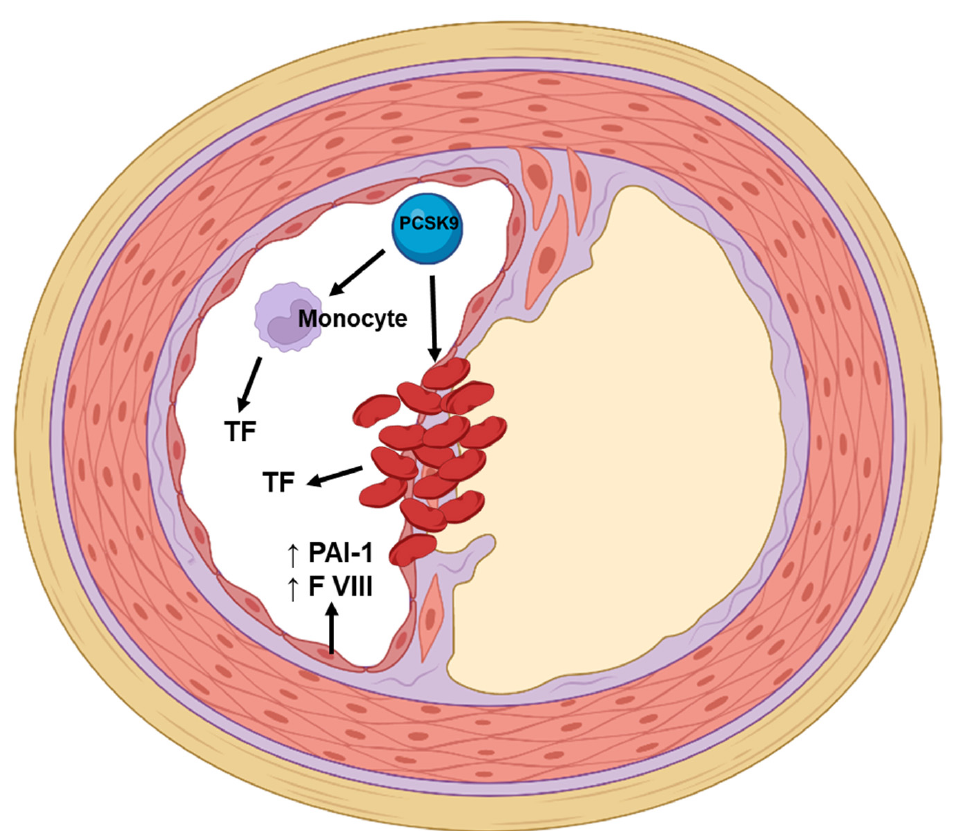
Figure 3. The role of PCSK9 in coagulation and fibrinolysis. PCSK9 induces the production of tissue factor, which is responsible for the activation of the extrinsic coagulation pathway and thrombus formation. TF, tissue factor; PAI-1, plasminogen activator inhibitor-1; F VIII, factor VIII. In patients with stable coronary artery disease, a positive and independent relationship between plasma PCSK9 level and platelet count was observed [64]. Not only platelet